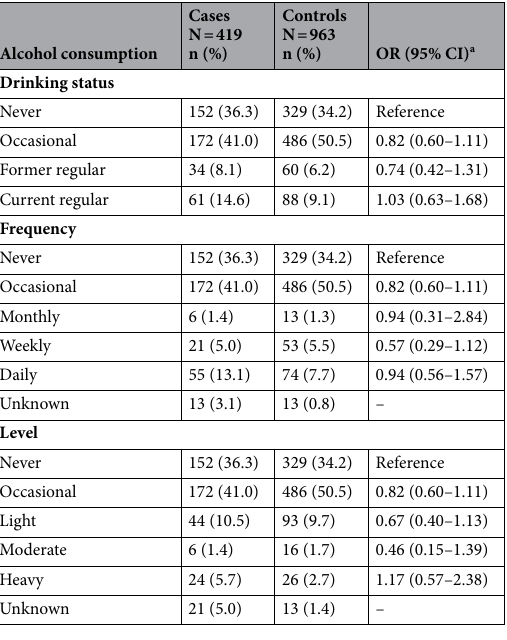
Table 2. The association between alcohol drinking and pancreatic cancer risk. CI confidence interval, N number, OR odds ratio. a OR and 95% CI were calculated using unconditional logistic regression, adjusted for sex, age, education, cigarette smoking (pack-years), oral hygiene score, vegetable consumption, allergy, diabetes/glucose intolerance and BMI at two years before the pancreatic cancer diagnosis for the cases or before the interview date for the